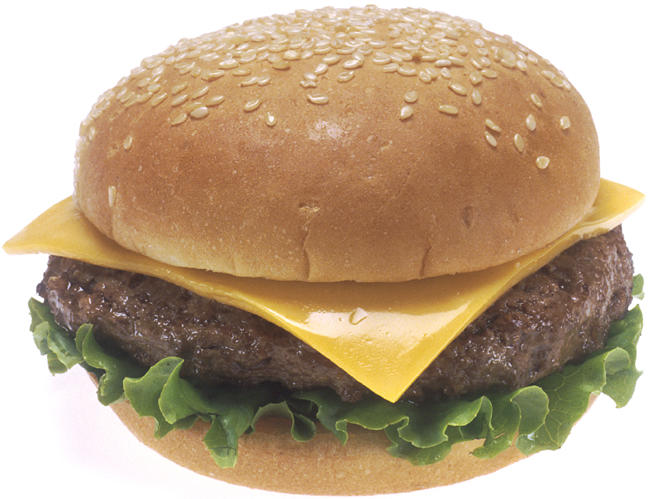
A shift towards “Western diets” high in saturated fats is occurring in developing countries(Photo: Renee Comet/National Cancer Institute)